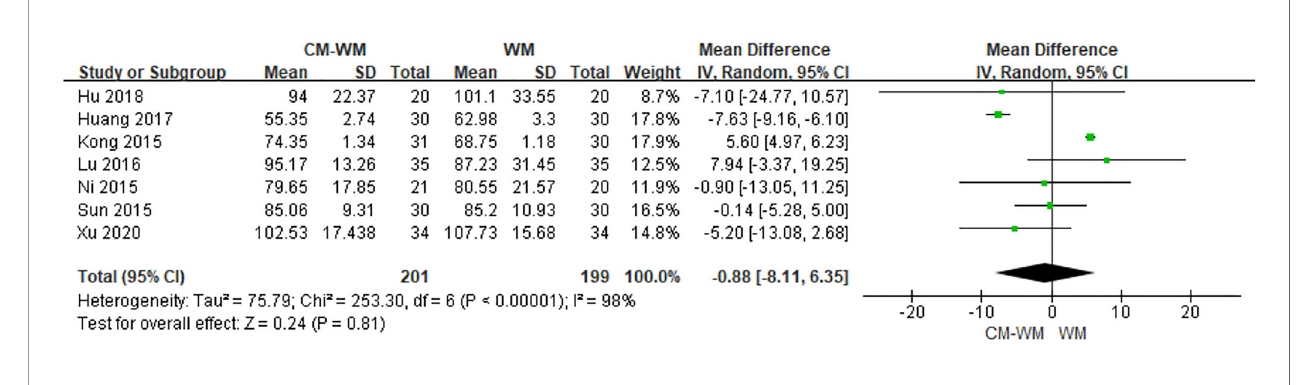
FIGURE 15 | Meta-analyses on ALP.